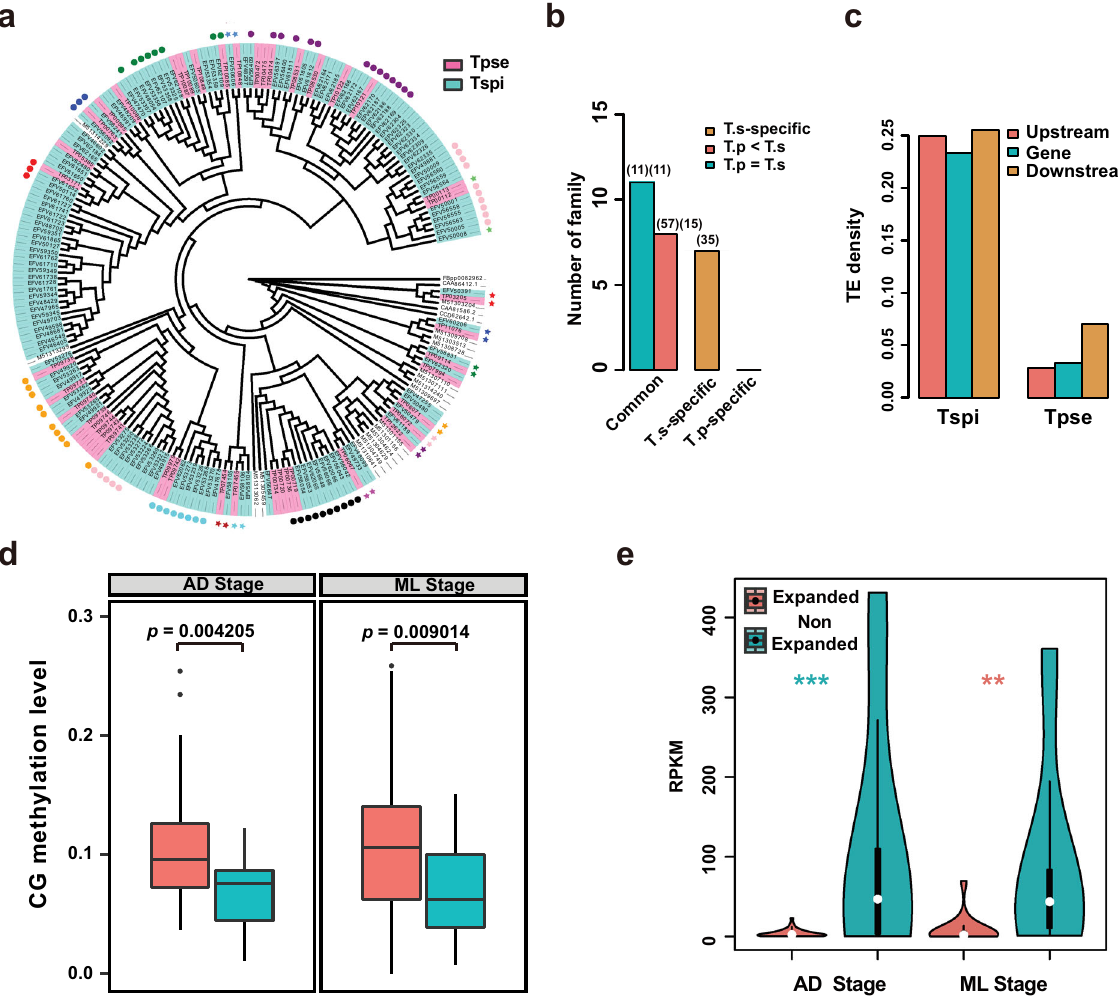
0.00.10.20.3 Fig. 3 Differential expansion of DNase II gene family between the two clades Trichinella . a Phylogenetic tree of DNase II gene family with T. pseudospiralis (colored in pink), T. spiralis (colored in cyan) and other three species (that is D. melanogaster , C. elegans and T. suis ). b Common and speci fi c number of DNase II family between T. pseudospiralis and T. spiralis . Numbers in the front and back brackets represent gene number and family number, respectively. c Comparison of the average density of transposon element ( y -axis) around DNase II loci and their two-kilobase fl anking regions upstream and downstream in T. pseudospiralis and T. spiralis ( x -axis). d Comparison of methylation level between expanded (red) and non-expanded (green) DNase II genes in Ad (left) and ML (right) stages in T. spiralis . P values were calculated using Mann – Whitney U test. e Comparison of expression level between expanded (red) and non-expanded (green) DNase II genes in Ad and ML stages in T. spiralis . A Student ’ s t -test was applied to the pairwise comparison. *** indicates P < 0.001; ** indicates P < T. pseudospiralis . Sequence of TP12446 was con fi rmed by PCR analysis and cloned with a FLAG epitope tag into a lentiviral vector. (Supplementary Fig. 19), considering Trichinella reprograms term- inally differentiated skeletal muscle cells. Then, we produced three transgenic C2C12 cell lines: (1) normal cell (Blank), (2) an empty lentiviral vector PSE-CMV-NC (NC), 3) a lentiviral vector PSE- CMV-TP12446 with overexpression of TP12466 (OE). The trans- duction ef fi ciency was assessed by western bolt, which showed high protein expression of TP12446 in PSE-CMV-TP12446 group both at day 4 and 8 when comparing with normal cell and PSE-CMV-NC